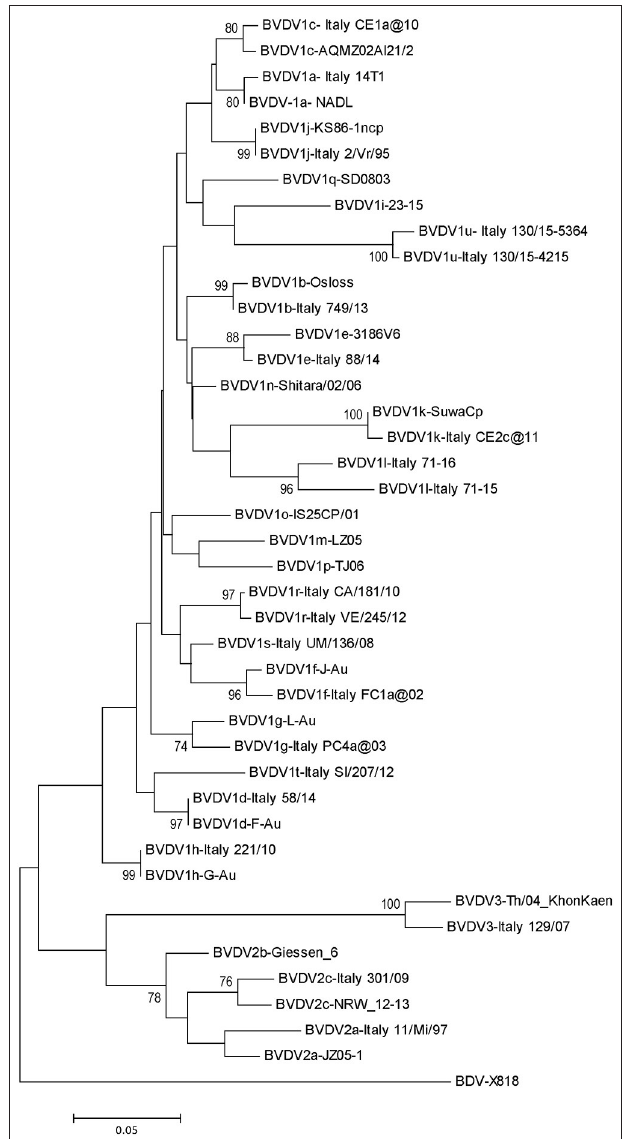
FIGURE 1 | Phylogenetic tree based on the 5 ′ -UTR of selected Italian sequences representative of pestiviruses detected in cattle and